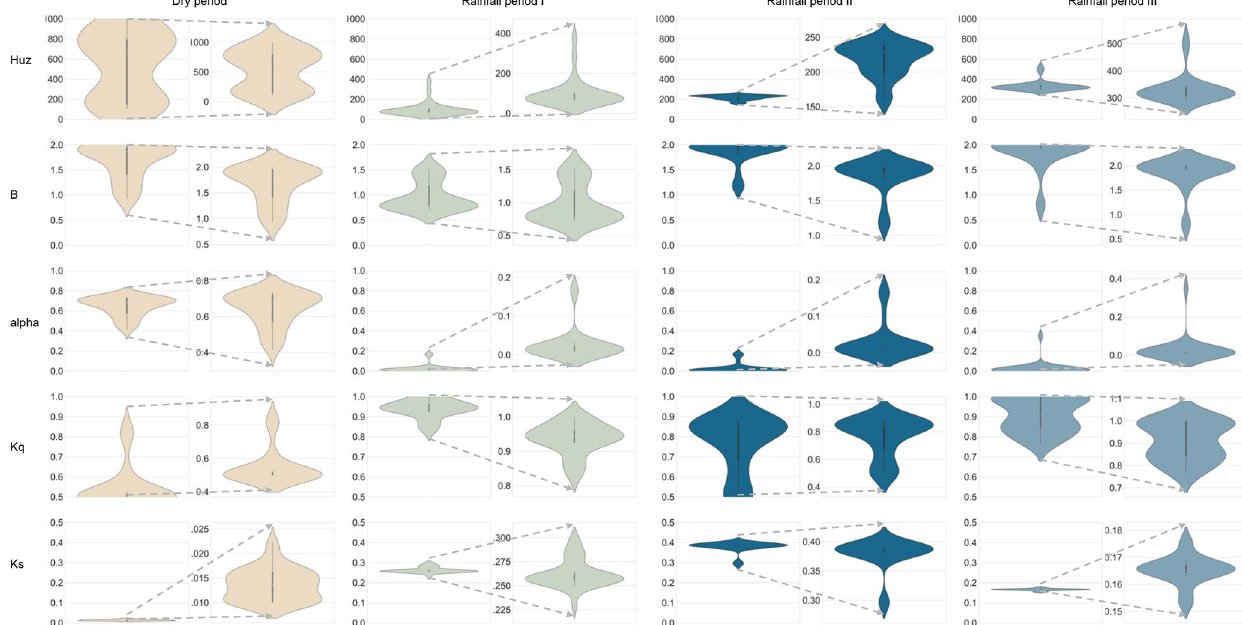
Figure 6. Evolutionary processes of seasonal dynamic parameters in the individual parameter spaces in the Hanzhong basin.